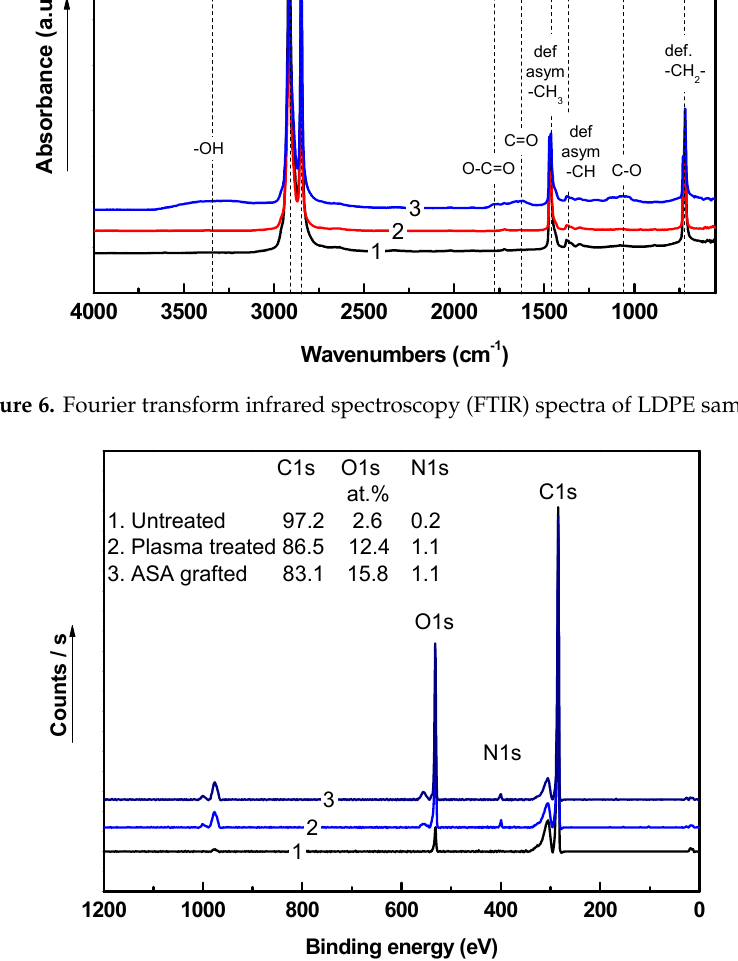
Figure 7. X-ray photoelectron spectroscopy (XPS) spectra of LDPE Figure 7. X ‐ ray photoelectron spectroscopy (XPS) spectra of LDPE samples.